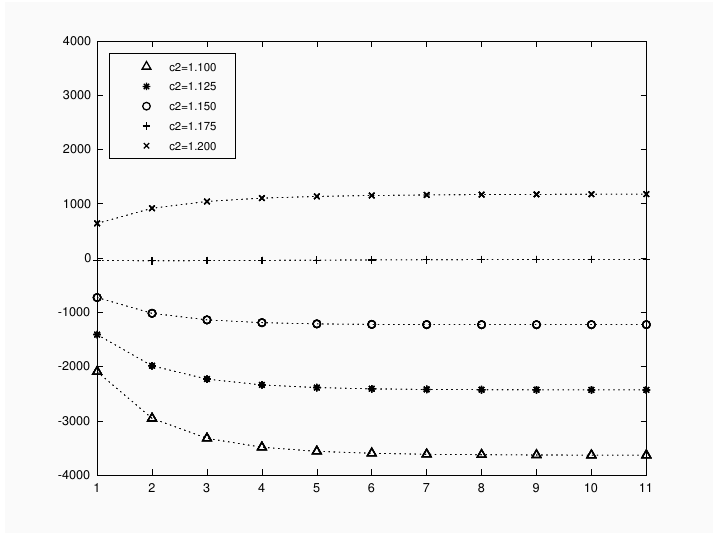
Figure 4. Expected Benefit versus initial